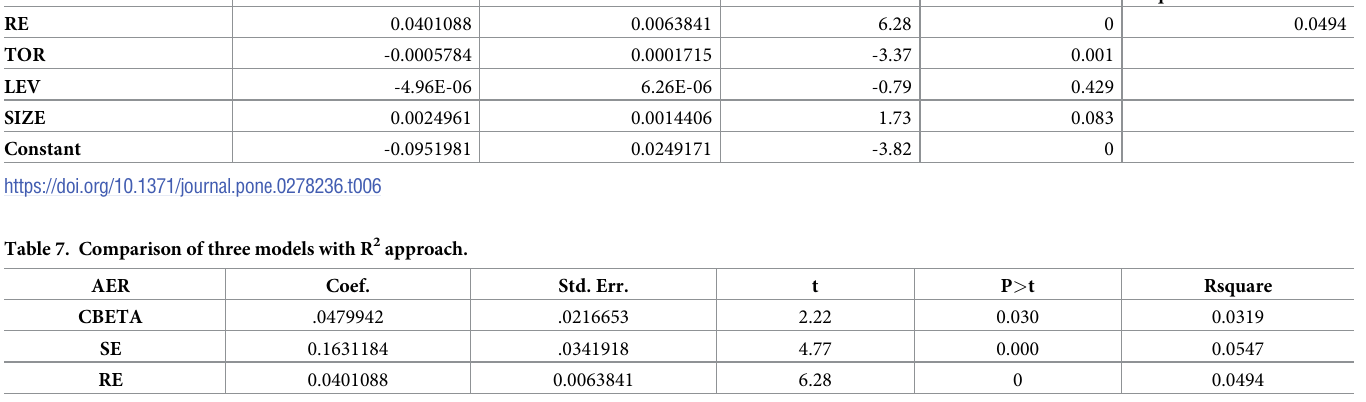
Table 6. Rennyi entropy fixed effect results. AER Coef.